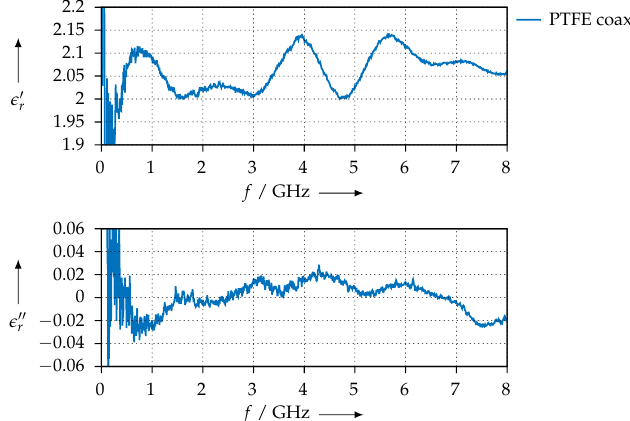
Figure 10. Extracted permittivity of the PTFE reference sample measured with the coaxial setup.